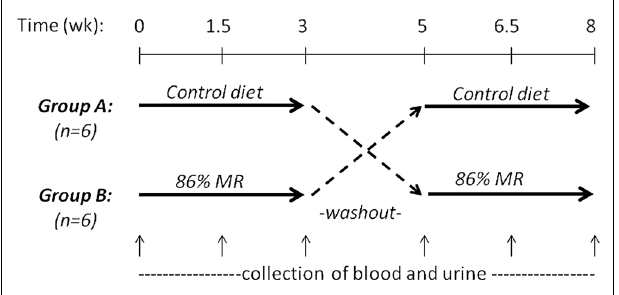
FIGURE 2 | MR randomized controlled crossover feeding study